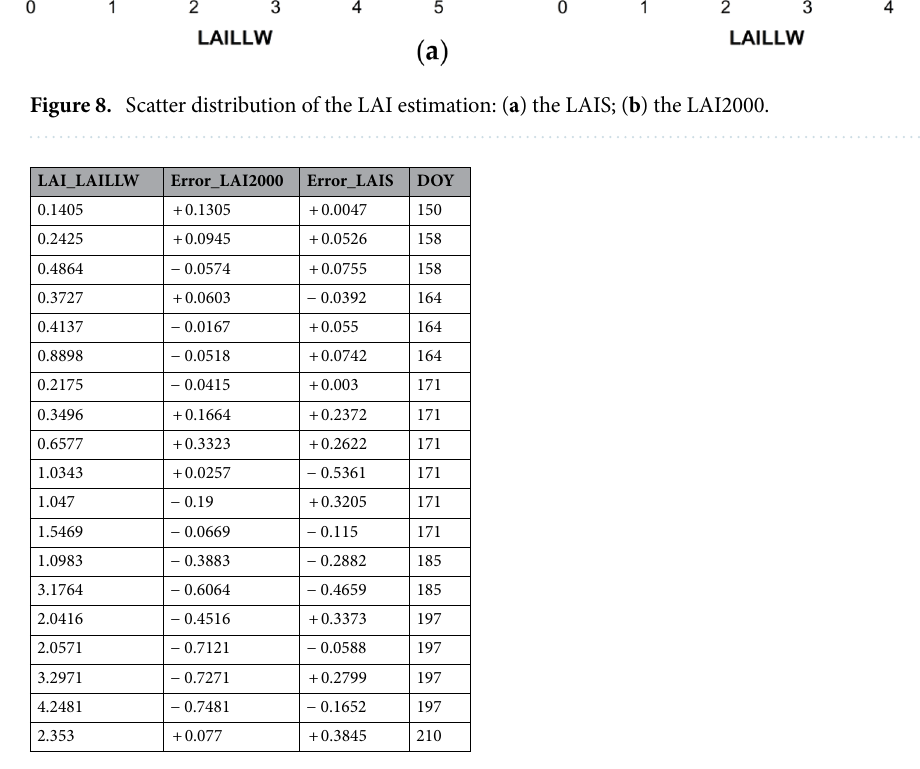
Table 5. The LAILLW data and the absolute errors between LAI2000 and LAIS data. 1 “ + ” indicates that the measured value is overestimated from the true value. 2 “−” indicates that the measured value is underestimated from the true